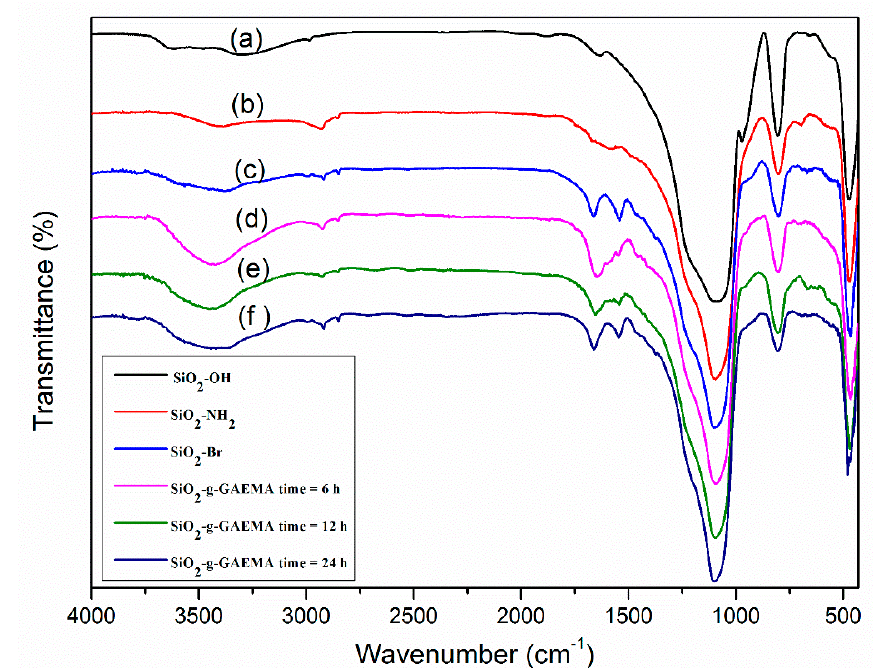
Figure 2 . The FT-IR spectra of (a) bare SiO 2 , (b) SiO 2 -NH 2 , (c) SiO2-Br, (d) SiO 2 -g-GAEMA (reaction time = 6 h), (e) SiO 2 -g-GAEMA (reaction time = 12 h), and (f) SiO 2 -g-GAEMA (reaction time = 24 h).